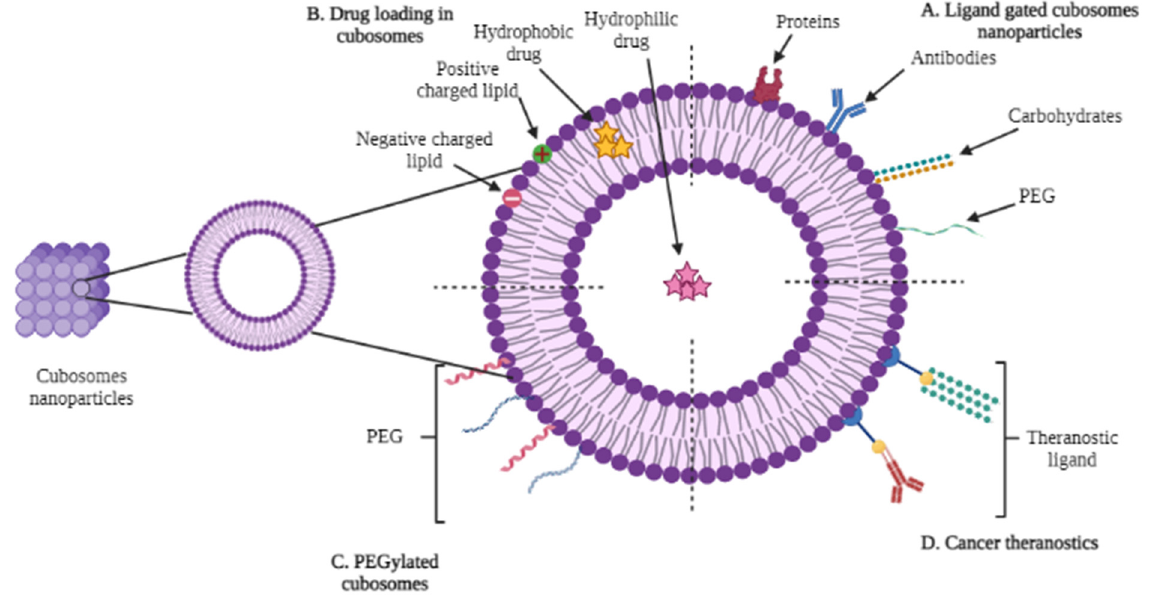
Figure 1. Cubosomes exhibiting internal and cubic structures with potential of drug delivery.